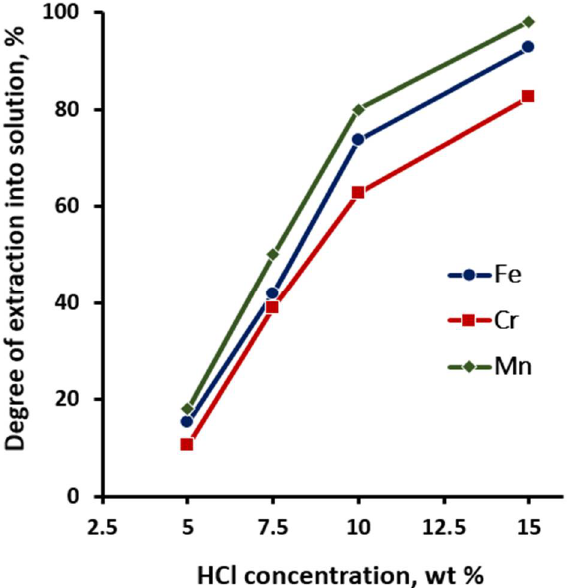
Figure 6. Dependence of the purification degree of titanium dioxide from iron, chromium, and manganese on the concentration of hydrochloric acid in solution.